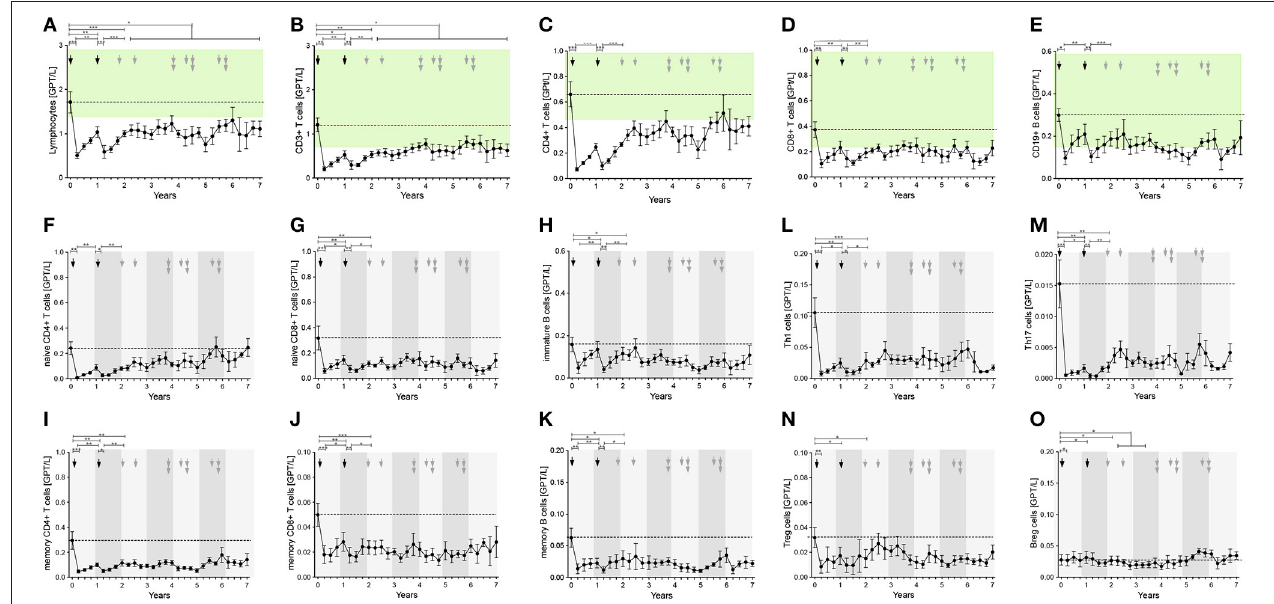
FIGURE 5 | Distribution of peripheral immune cell subsets in patients with reappearance of disease activity after 1st and 2nd ATZ (partial-responder). Distribution of absolute count of peripheral immune cell subsets before (0 years) and up to 7 years follow up are depicted. Mean values + / − SD of absolute count of lymphocytes (A) , T cell (B–D, F,G, L–J, N) and, B cell (E,H,K,O) , subsets are shown. Reference ranges are marked by pastel green color and baseline values are highlighted by the dotted line. Arrows in black indicate 1st and 2nd ATZ infusions, arrows in gray indicate time point of ATZ retreatment in individual patients. Asterisks demonstrate statistical significance (* p < 0.05, ** p < 0.01, *** p <